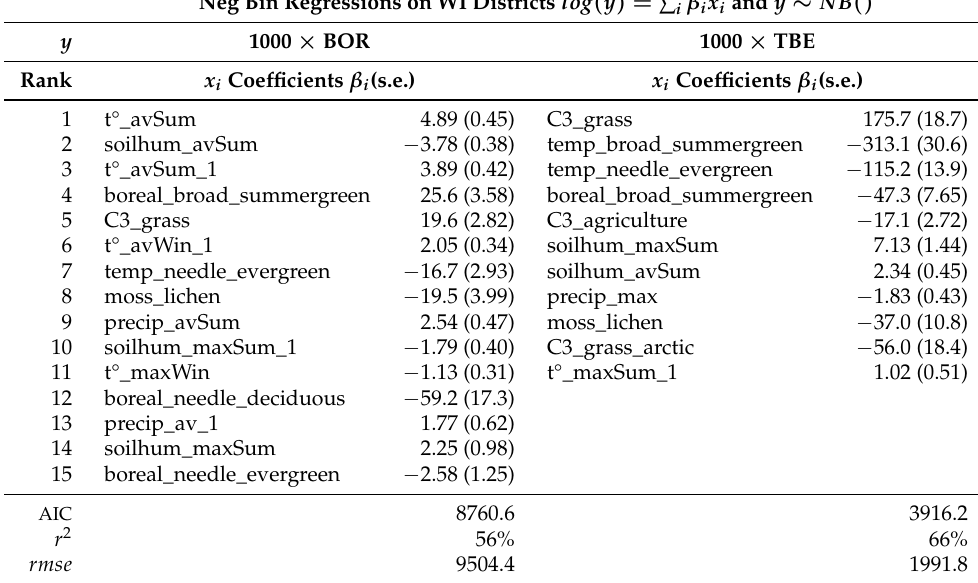
Table 3. Negative binomial regression models for BOR and TBE incidences with biome PFTs and climate as explanatory variables over the whole 1992–2015 period. (Biome PFTs have been partially abbreviated: temp is for temperate, broad is for broadleaf, and needle is for